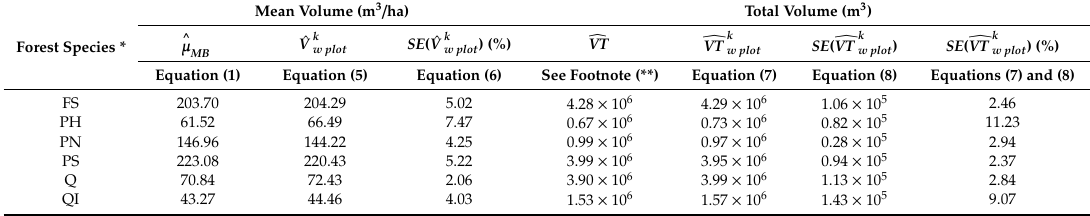
Table 5. Volume estimates and standard errors based on sampling variability in model calibration dataset.